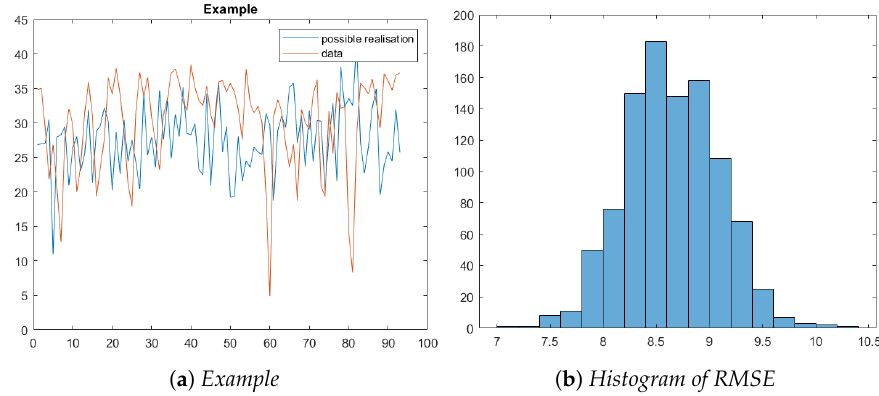
Figure 11. Use of only the summer of 2016 for possible data of summer in 2017.